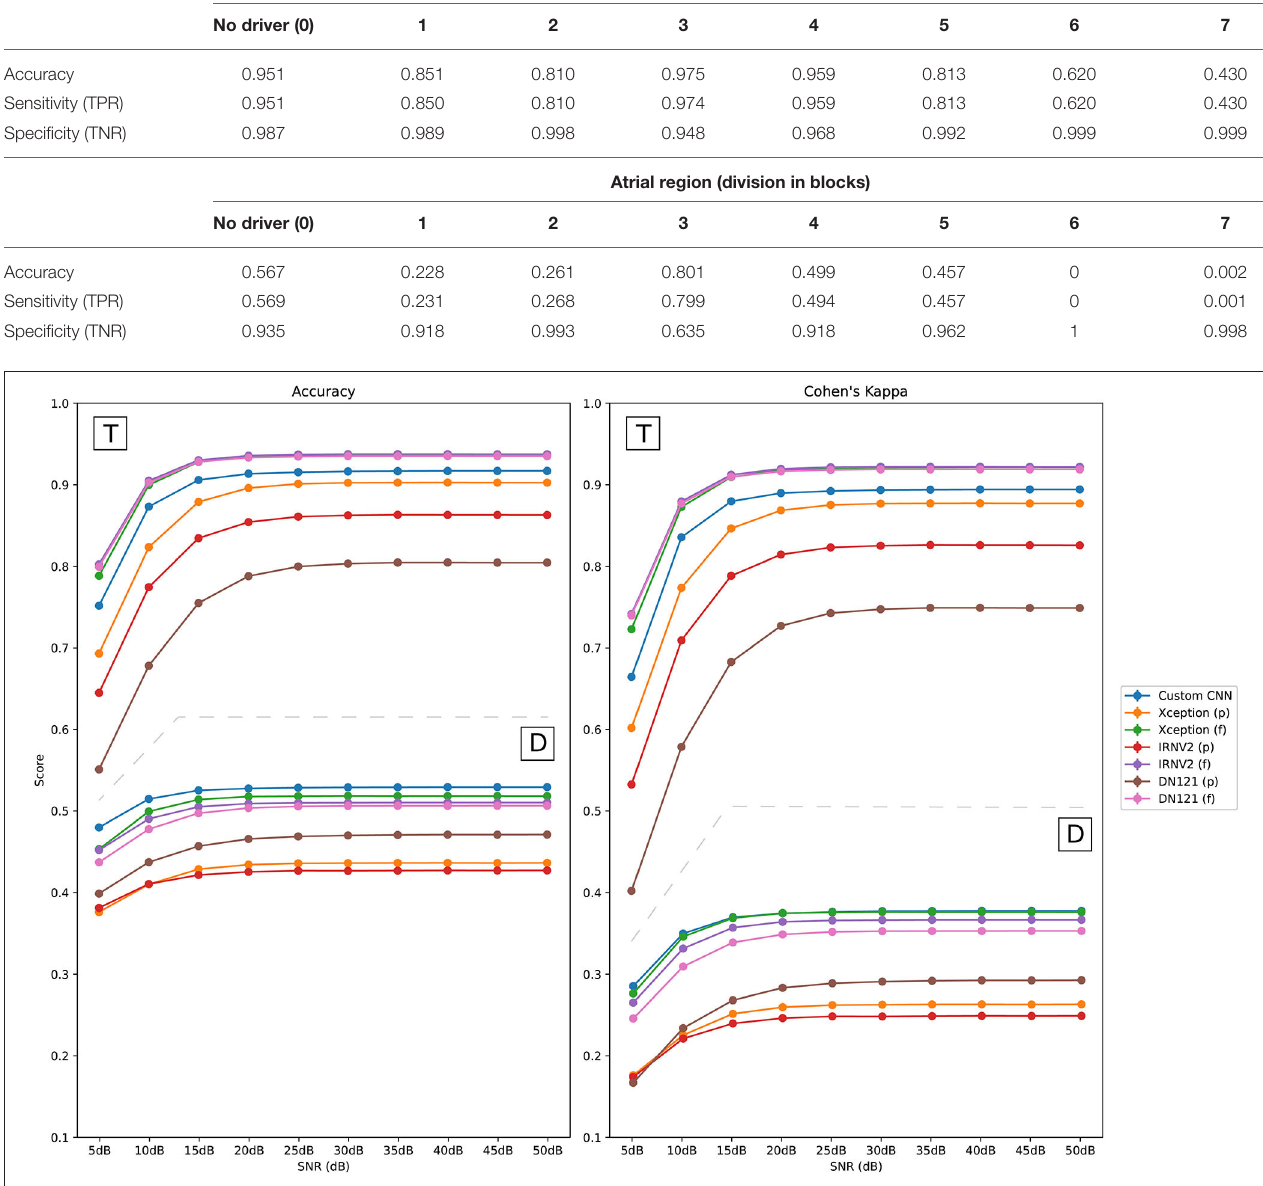
TABLE 2 | Accuracy, sensitivity, and specificity scores obtained with 1-channel CNN assuming time independence and division in blocks (by labels, test set). Atrial region (time independence)